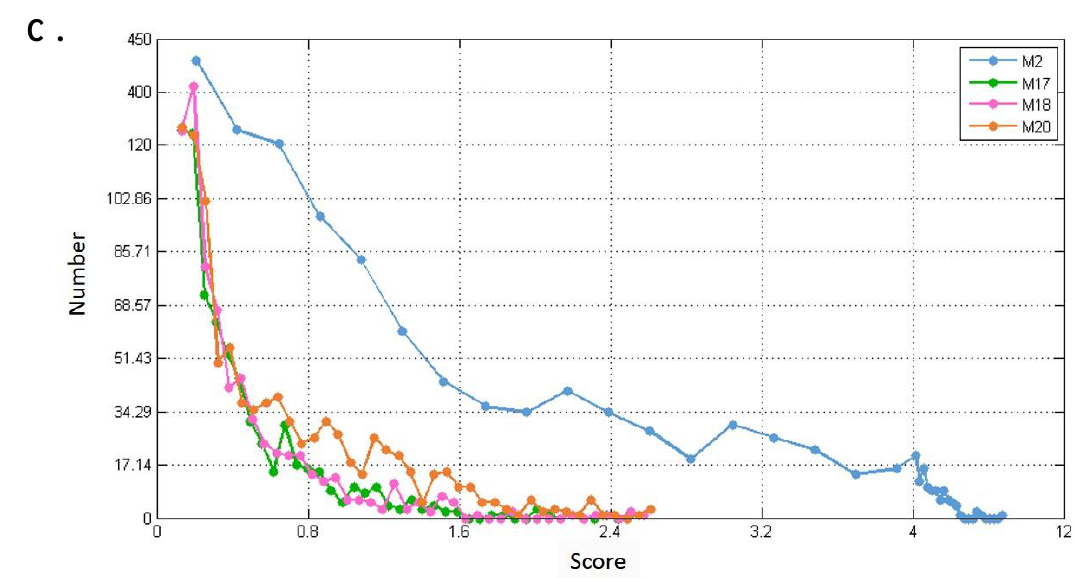
Figure 11. Distribution of connection strengths between four modules and their corresponding first-order genes in three tissue-specific networks. The X axis represents the connection strength. The Y axis indicates the number of first-order genes of modules. ( A – C ) show blood, breast, and prostate TSPPI networks, respectively.